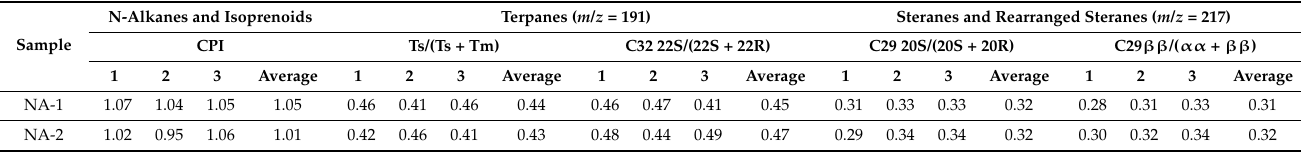
Figure 13. Analysis of C 29 sterane 20S/(20S + 20R) and C 32 hopane 22S/(22S + 22R) on maturity. Table 5. Geochemical parameters of field pyrolysis